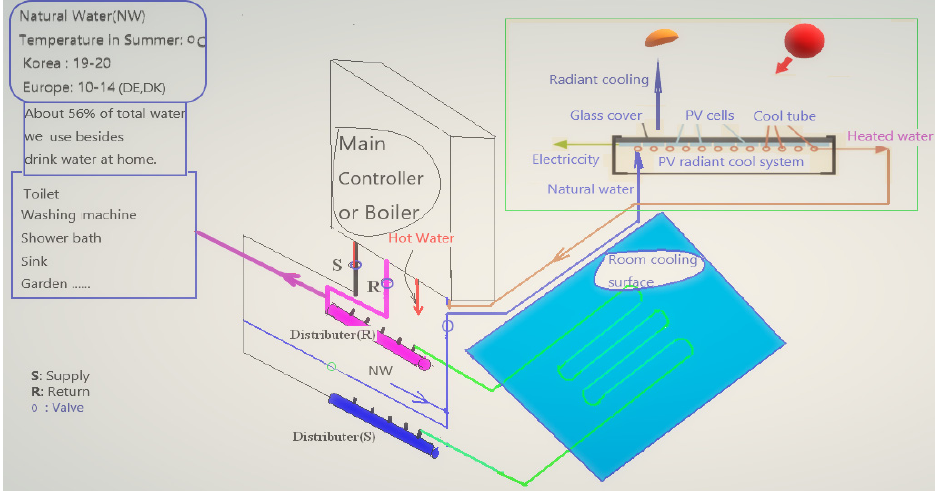
Figure 1. Principles of radiant cooling without any energy input.